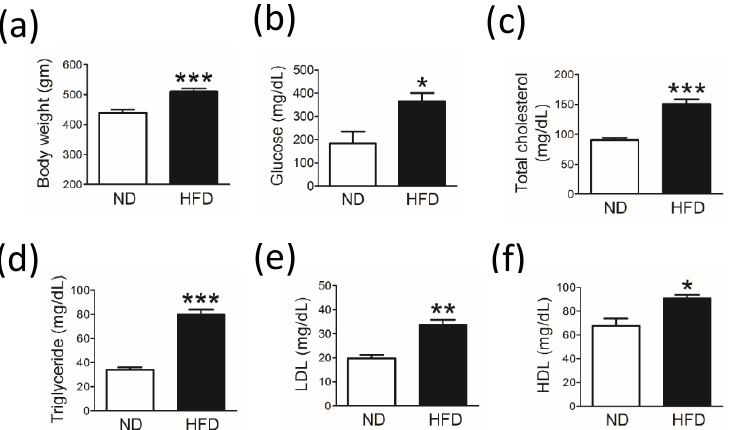
Figure 1. Laboratory data for middle-aged rats fed a normal diet (ND; control, n = 8) or a 45% high-fat diet (HFD; n = 8) for 30 weeks. Bar graphs show the mean ( ± SEM) values at the end of 30 weeks for ( a ) body weight, ( b ) blood glucose level, and blood lipid levels including ( c ) total cholesterol, ( d ) triglycerides, ( e ) low-density lipoprotein (LDL), and ( f ) high-density lipoprotein (HDL). * p < 0.05, ** p < 0.01, *** p < 0.001 vs ND group ( t